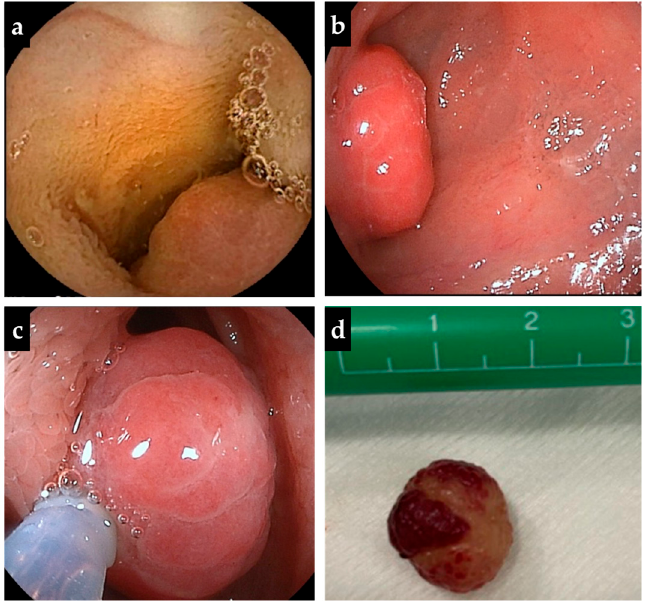
Figure 2. The findings of capsule endoscopy and double-balloon endoscopy. ( a ) Capsule endoscopy shows a polyp-like lesion at the upper jejunum, but no similar lesions are observed in other small intestinal segments. ( b , c ) A pedunculated polyp is found 75 cm anorectally from the pylorus and resected by cautery using a high-frequency snare. ( d ) The diameter of the resected polyp is 15